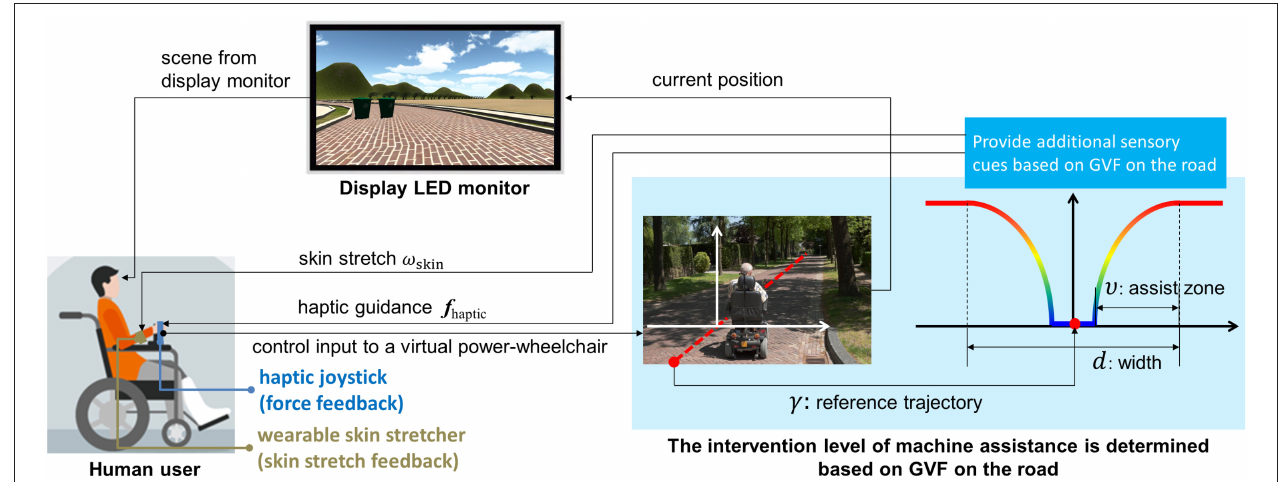
FIGURE 1 | The architecture of an assistive power-wheelchair simulator.